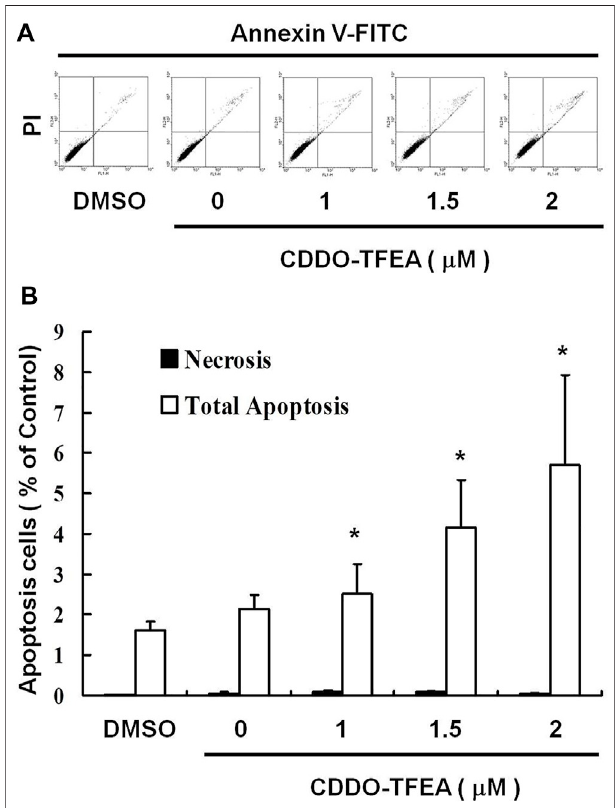
FIGURE 2 | CDDO-TFEA induced apoptosis in GBM8401 cells. (A) Annexin V-FITC and (B) Propidium Iodide (PI) staining. Results are expressed as a percentage of the control, with the control being 100%. All data are reported as means ± standard errors of the mean on the basis of the results of at least three separate experiments. Statistical analysis was performedusingthe t test,withdifferencesbetweenthetreatmentandcontrol groups considered signi fi cant at p < 0.05, as denoted by